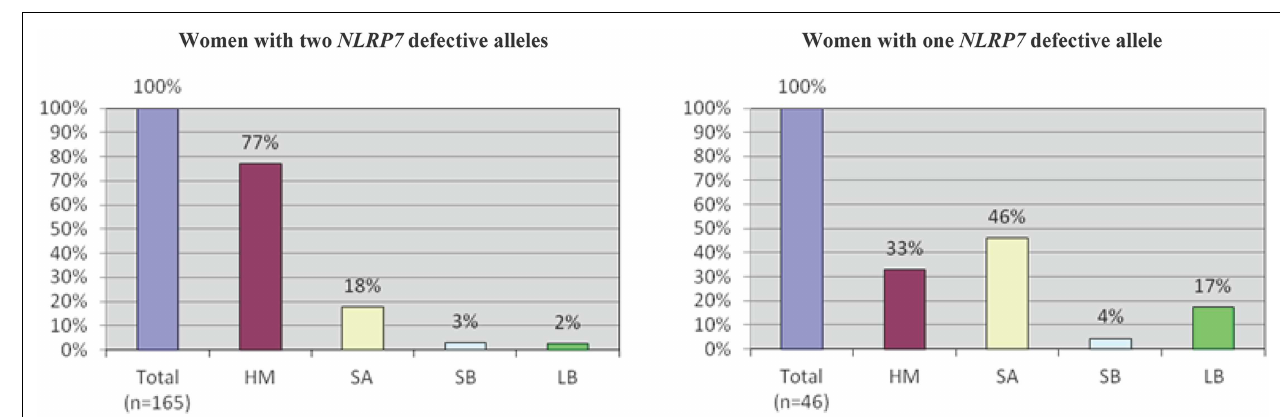
hydatidiform mole; SA, spontaneous abortion; SB, stillbirth; and LB, live birth. A higher incidence of HMs and a lower incidence of live births are observed in patients with two defective